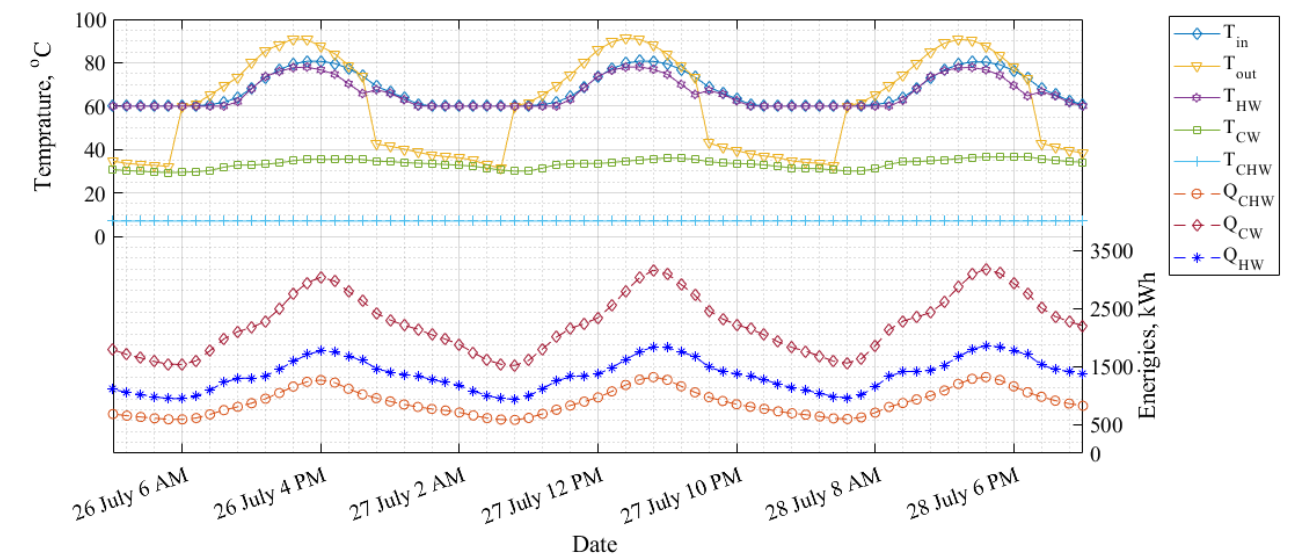
Figure 21. Temperature and energy distribution over three consecutive days during summer- time ADC